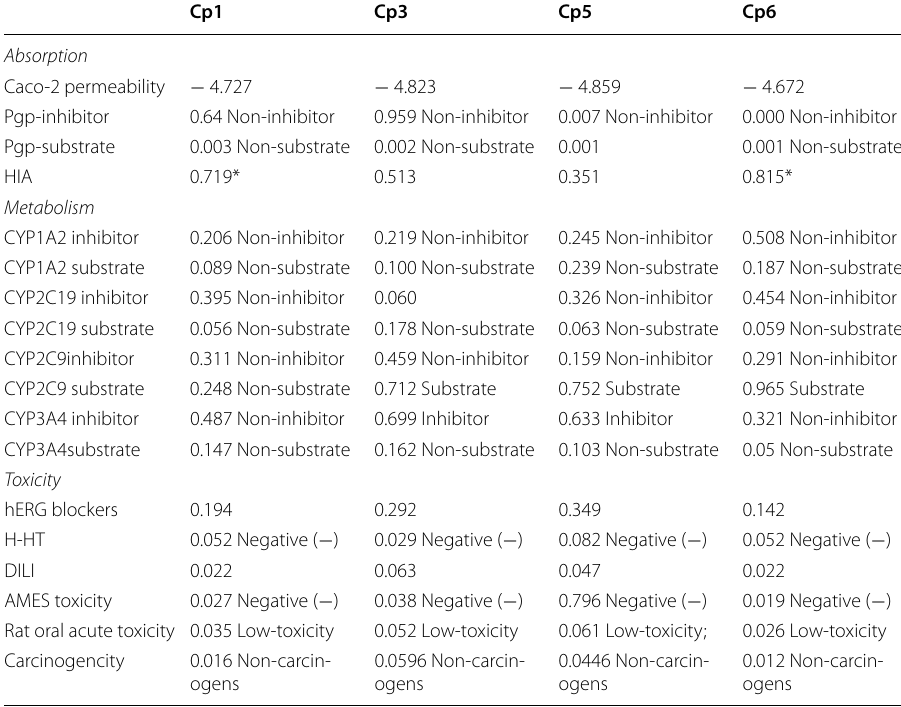
Table 3 ADMET prediction of Absorption, Metabolism and Toxicity of the four candidate drug